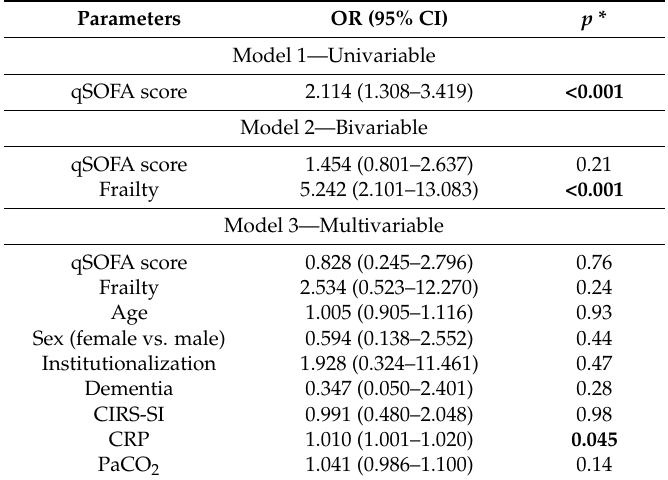
Table 2. Logistic regression analysis showing the association of qSOFA score at admission with the primary study outcome (in-hospital mortality) in elderly patients with suspected sepsis ( n =